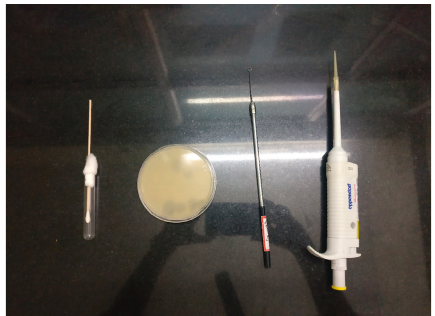
Figure 2: Armamentarium.